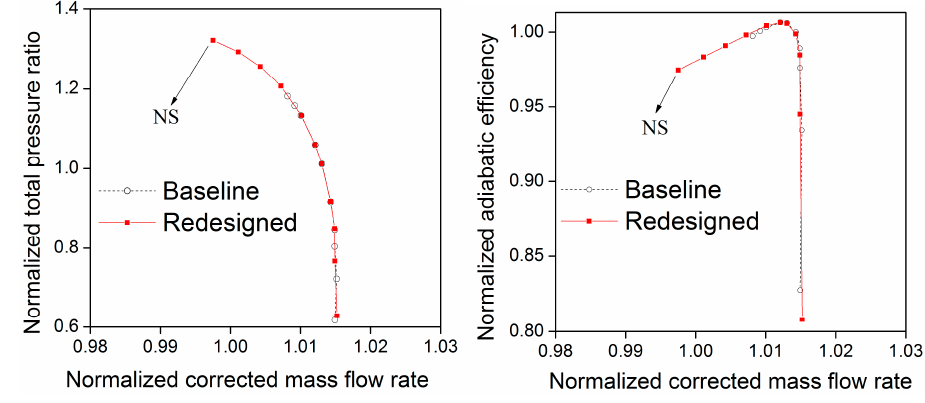
Figure 21. Overall performances.